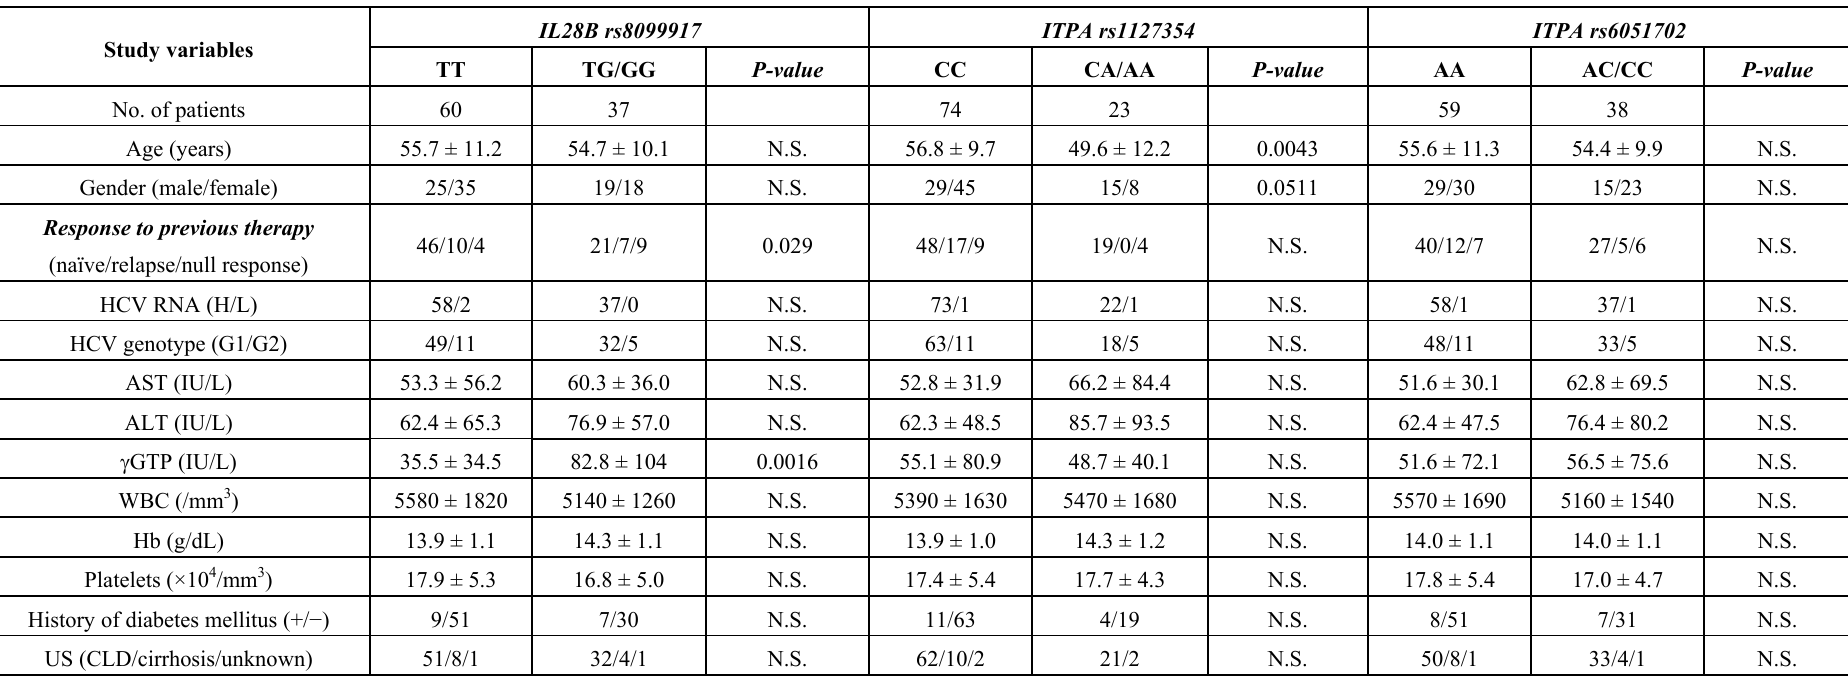
Table 2. Baseline characteristics of patients grouped according to IL28B and ITPA genetic variations.